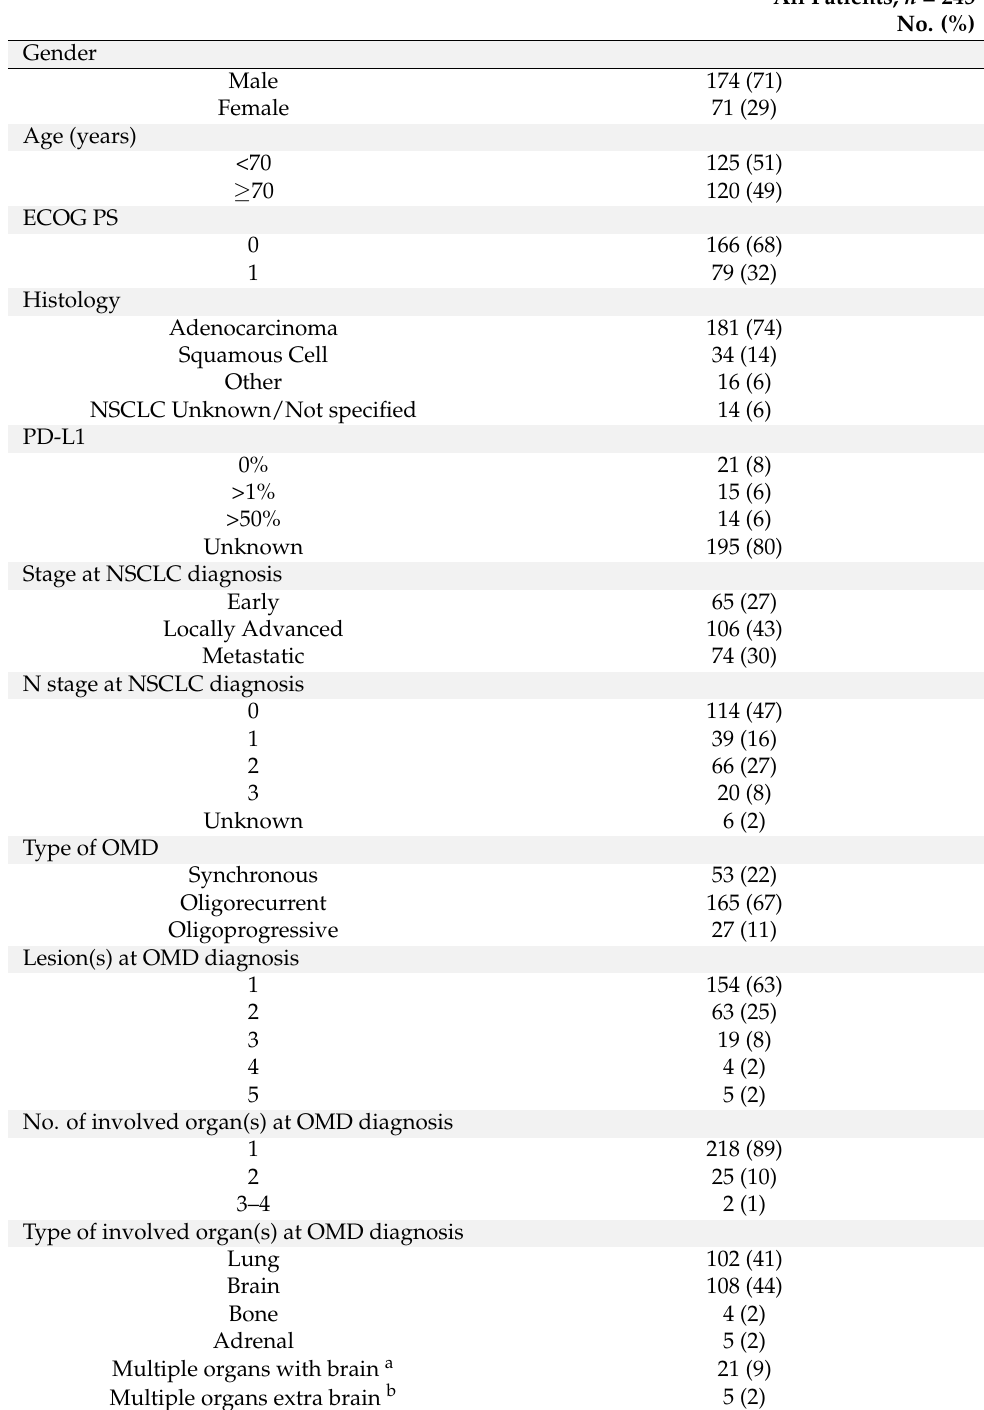
Table 1. Patients baseline